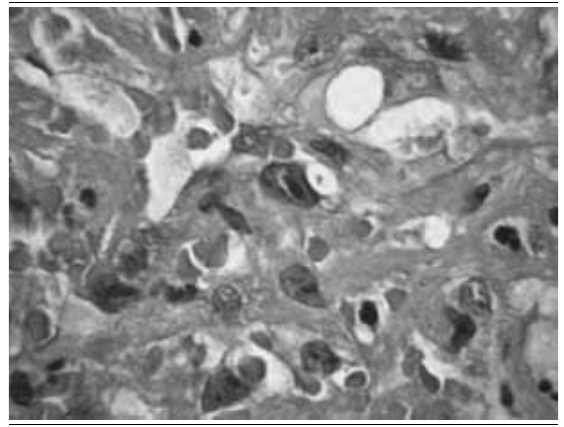
figurE 2 – HEE (HE, 40×) Large neoplastic cells with wide cytoplasm and hyperchromatic nucleus. HEE: epithelioid hemangioendothelioma; HE: hematoxylin and eosin.